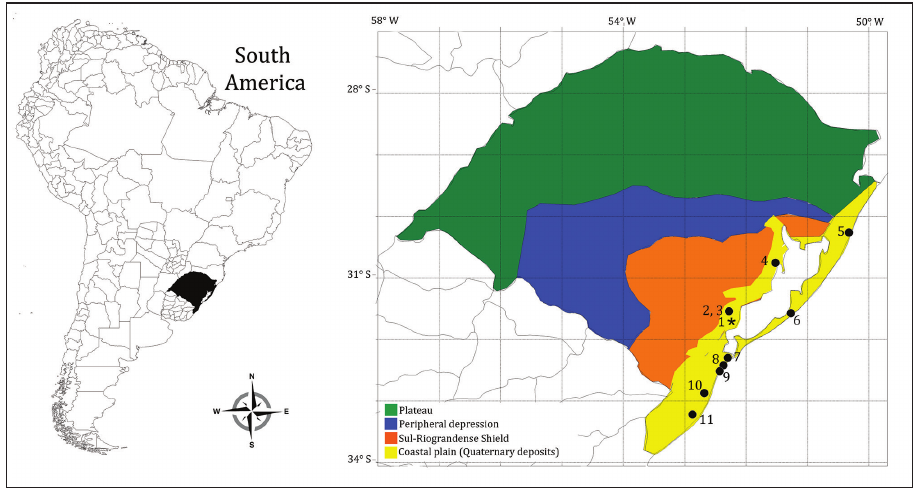
Figure 1. Four main geological formations from the state of Rio Grande do Sul, Southern Brazil. The study area (Quaternary deposits) as well as previous studies used in Dice Similarity Index analysis is en- tirely inserted in Coastal Plain. Key: 1 present study 2 Turuçu River basin; Burns et al. 2015 3 Corrientes Stream; Volcan et al. 2012 4 Tapes Butiazais ; Becker et al. 2007 5 Fortaleza lagoon; Schifino et al. 2004 6 Lagoa do Peixe; Loebmann and Vieira 2005 7 Peat forest; Quintela et al. 2007 8 Rio Grande coastal streams; Tagliani 1995 9 Cassino coastal streams; Bastos et al. 2013 10 Taim wetland; Garcia et al. 2006 11 Lagoa Mangueira; Artioli et al.